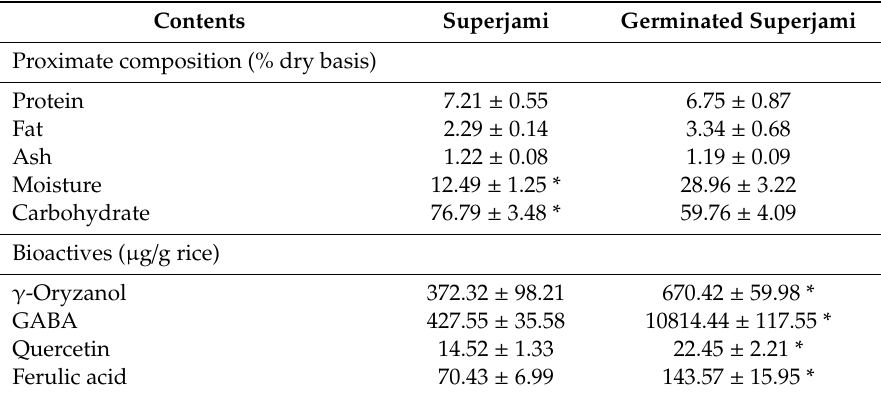
Table 1. Proximate compositions and bioactives of Superjami.